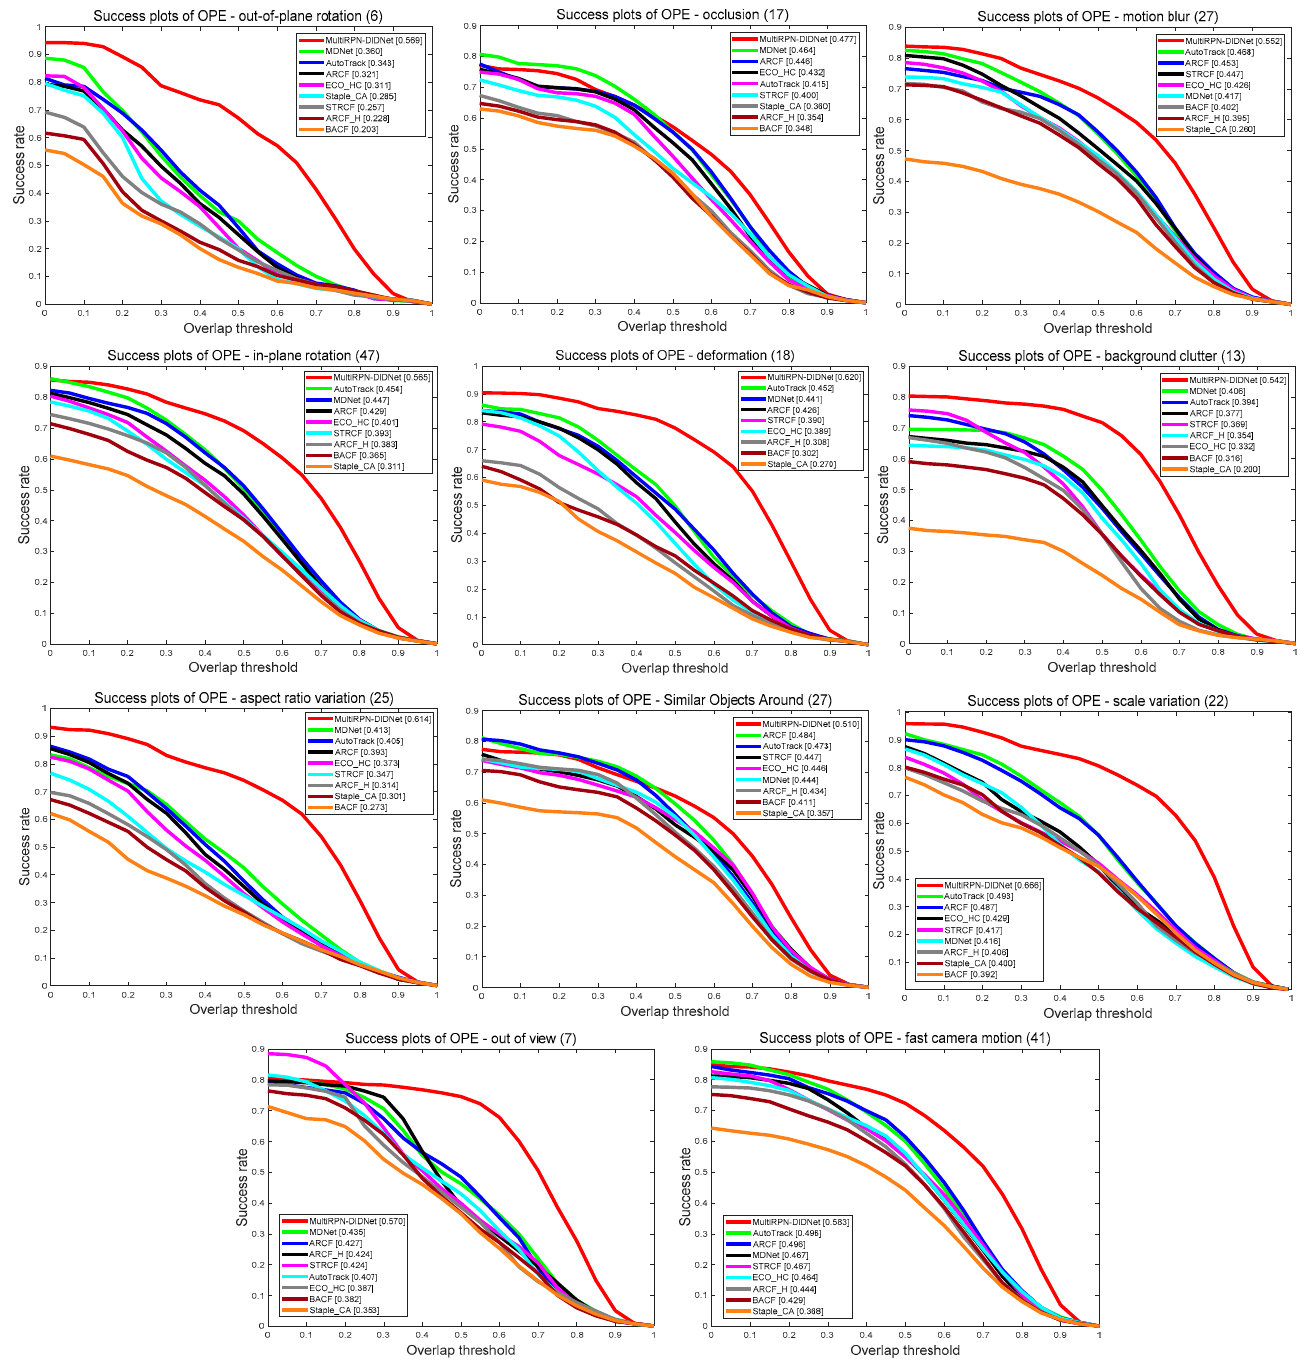
Figure 5. AUC comparison results of several state-of-the-art trackers on the DTB70 dataset. From left to right and top to down are the success rate plots under OPR, OCC, MB, IPR, DEF, BC, ARV, SOA, SV, OV and FCM video attributes.